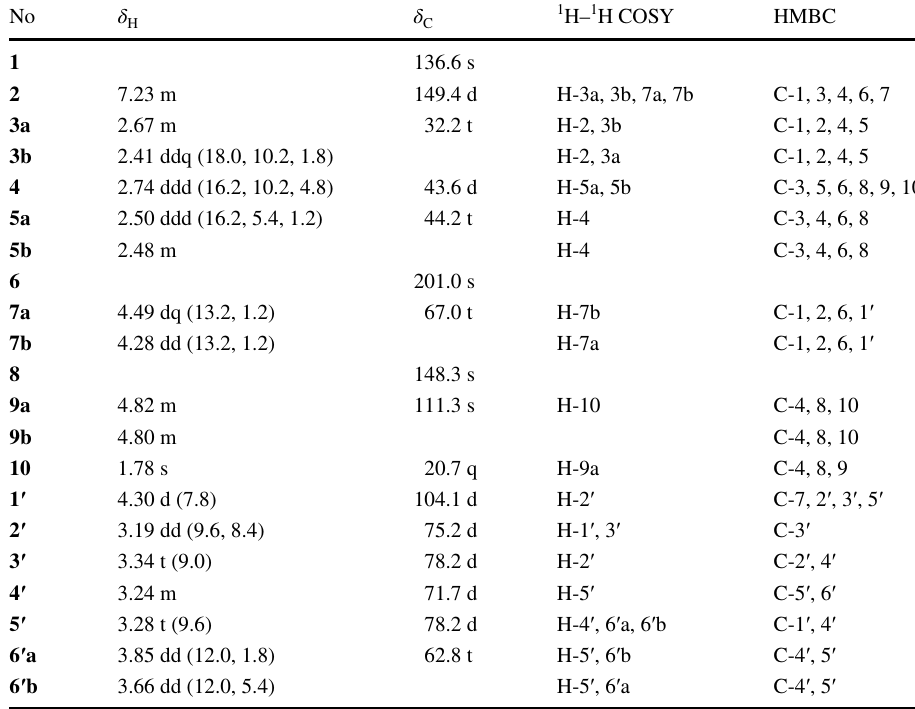
Table 1 1 H NMR (600 MHz, CD 3 OD) and 13 C NMR (150 MHz, CD 3 OD) data for compound 1